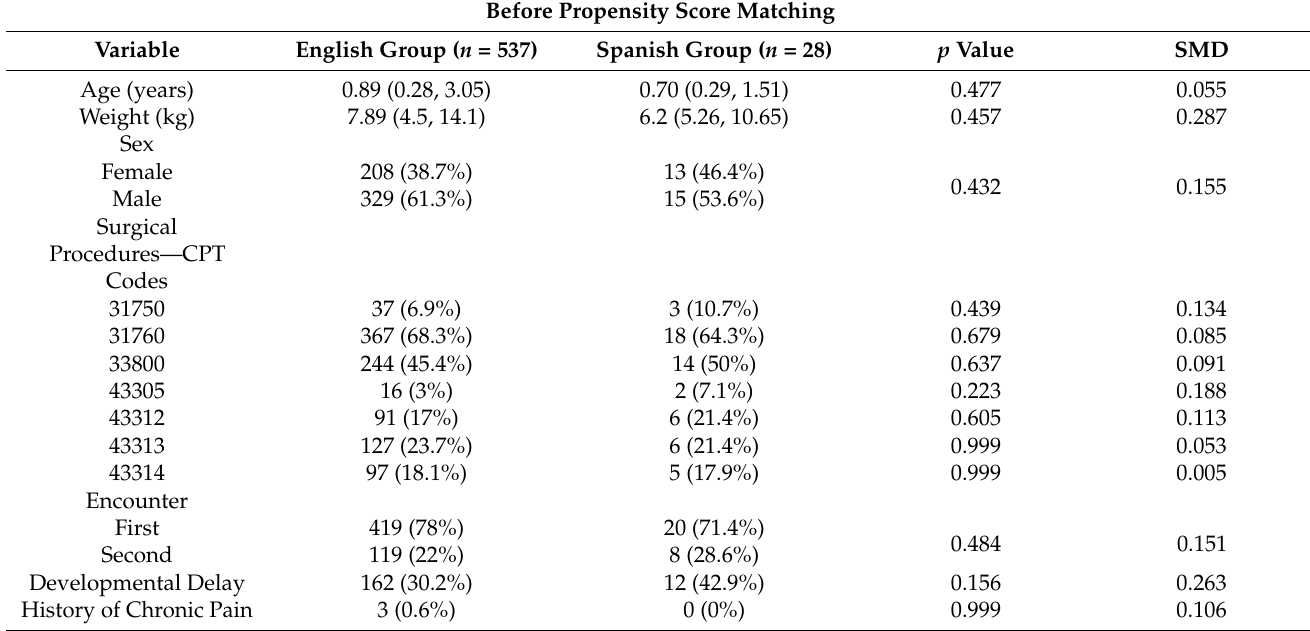
Table 3. Patient Characteristics Before and After Propensity Score Matching Between English- and Spanish-Speaking